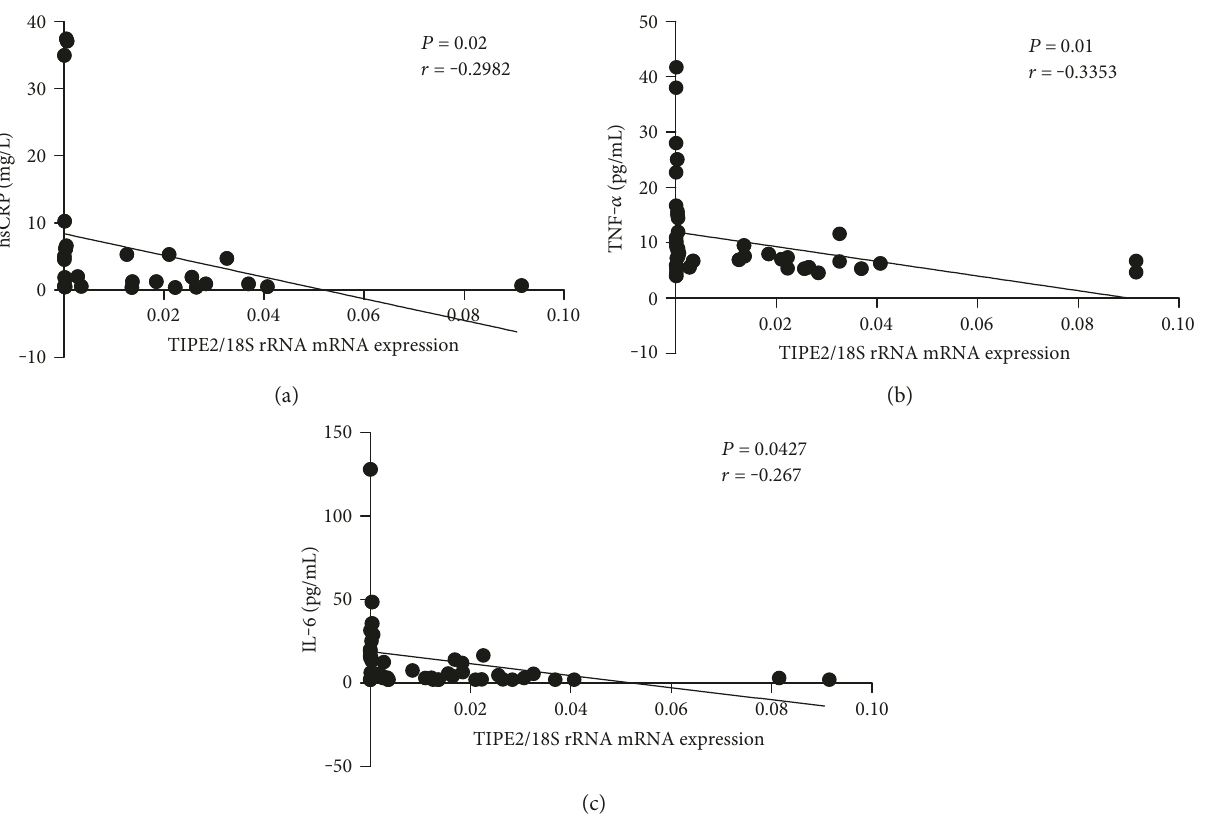
Figure 2: Correlation analysis of TIPE2 mRNA expression and hsCRP, TNF- α , and IL-6 concentrations in participants with T2DM. TIPE2 mRNA expression was determined by RT-PCR, whereas serum concentrations of hsCRP, TNF- α , and IL-6 were determined using a nephelometer or by ELISA. Pearson ’ s correlation analysis was used for statistical comparisons. A negative correlation was found between TIPE2 mRNA and hsCRP (a), TNF- α (b), and IL-6 (c) concentrations in T2DM patients. Every point shows information from a speci fi c